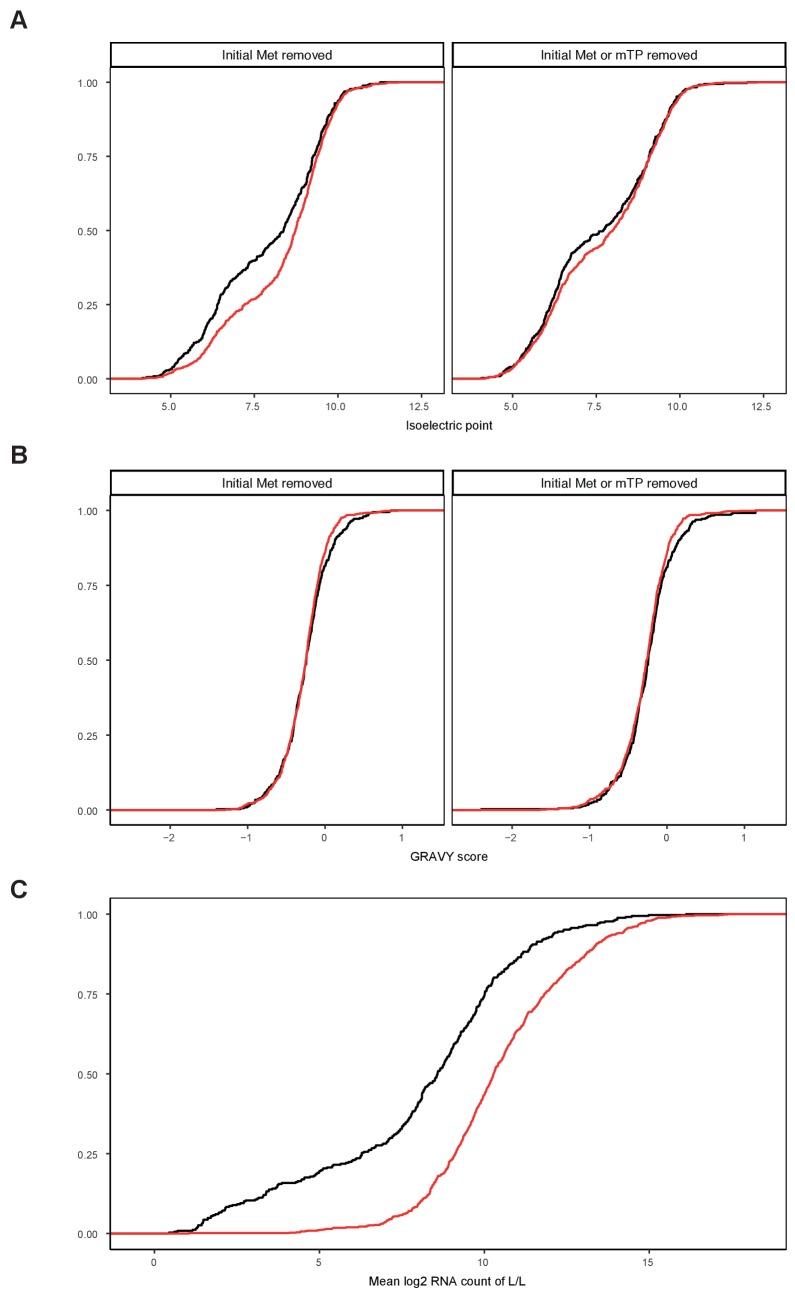
Analysis of systematic bias in the detection of mitochondrial proteins.Cumulative distribution plots for mitochondrial proteins based on (A) GRAVY score as a measurement of hydrophobicity removing either only the first methionine of the amino acid sequence (left) of the first methionine and the mitochondrial targeting peptide (right). (B) Isoelectric point as a measure of charge hydrophobicity removing either only the first methionine of the amino acid sequence (left) of the first methionine and the mitochondrial targeting peptide (right). (C) mean RNA counts of L/L samples across all mouse strains as a measure of protein abundance. Met, methionine; mTP, mitochondrial targeting peptide; black, detected in at least one knockout mouse strain; red, not detected.